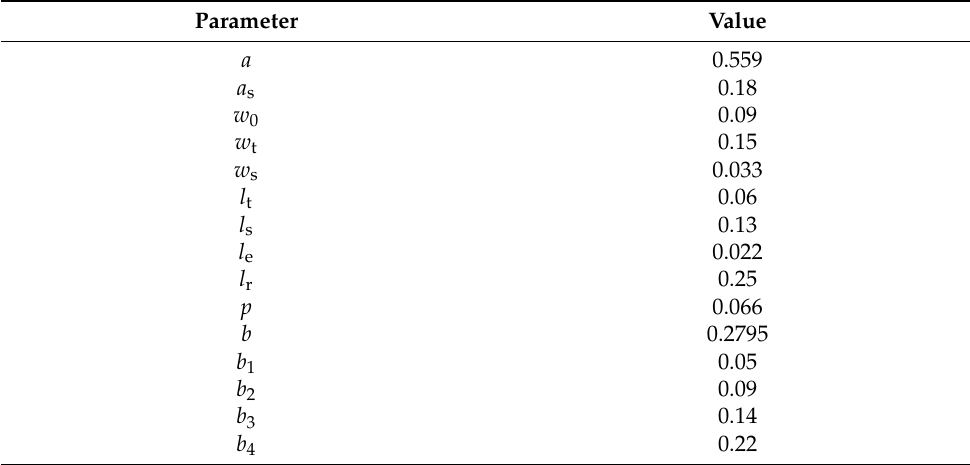
Table 1. Dimensions of the proposed MSL-to-RWG transition (unit: